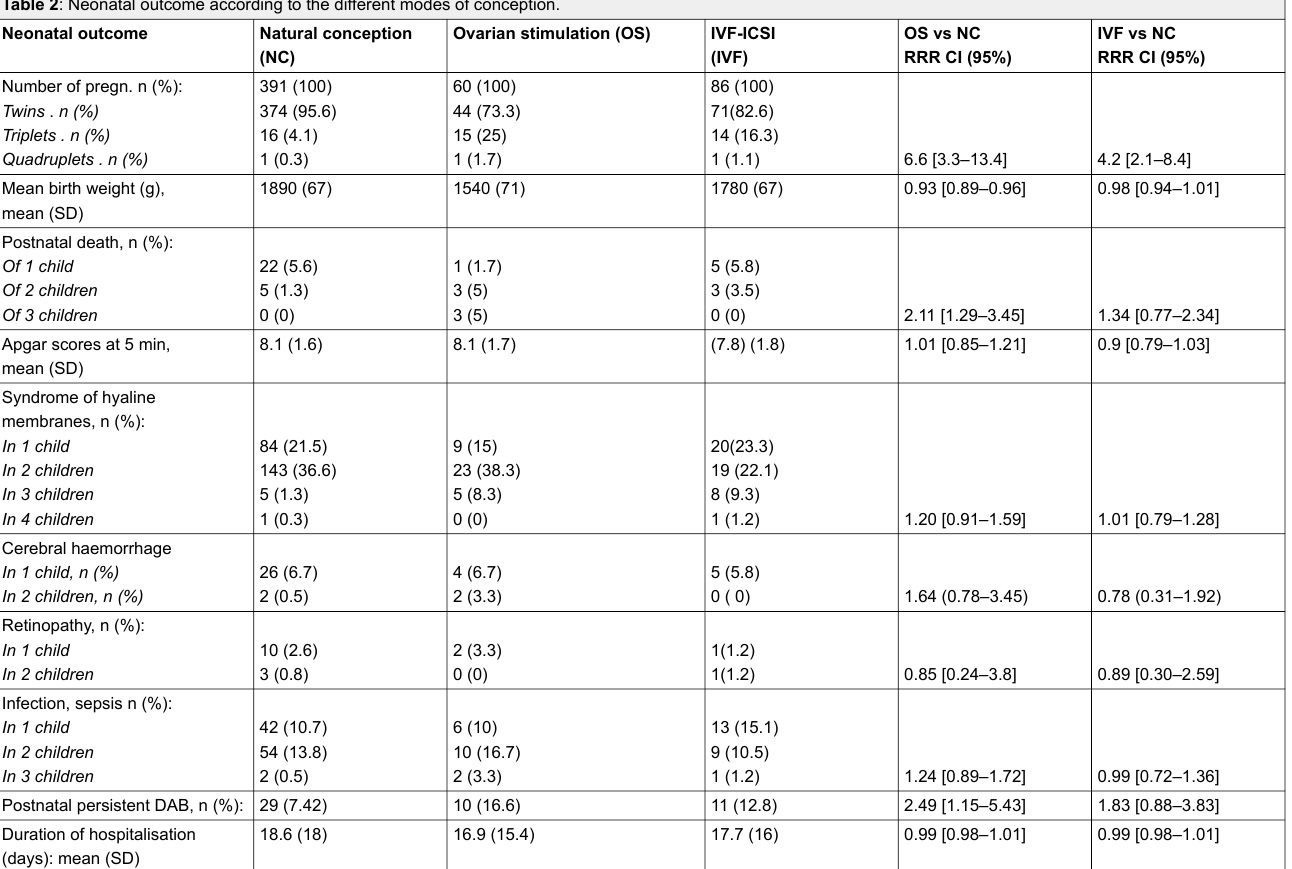
Ovarian stimulation (OS) IVF-ICSI